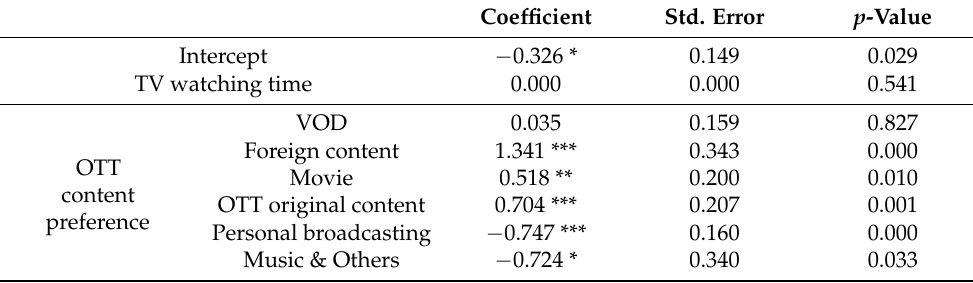
Table 9. Logistic regression results on paid service experience. Coefficient Std. Error p -Value Intercept − 0.326 * 0.149 0.029